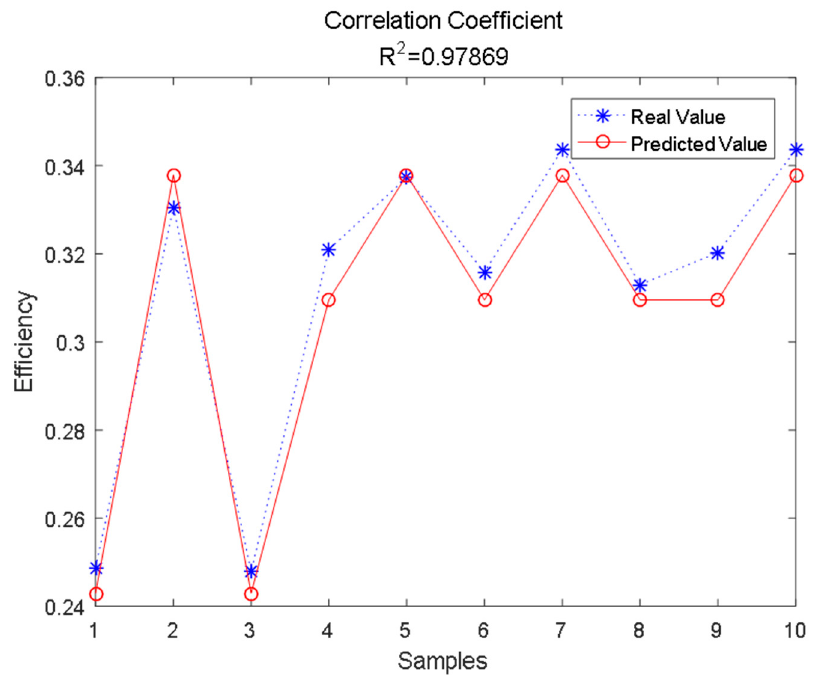
Figure 11. Efficiency predicted value by BP with learning rate optimization ( η = 0.4934).